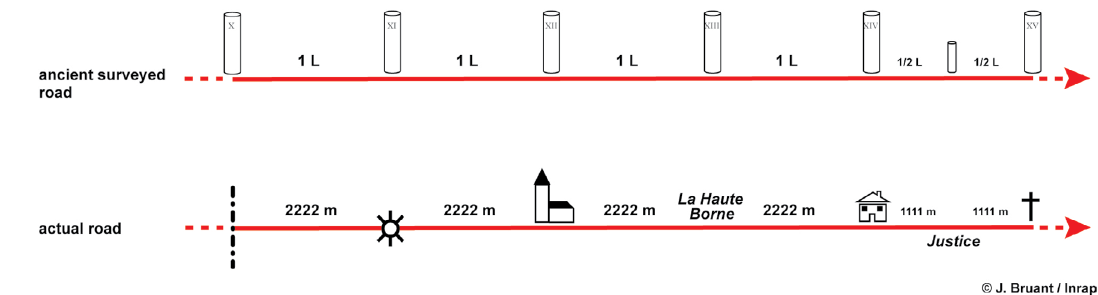
Figure 6. The topographical remanence of the leaguestones on the road networks. © J.